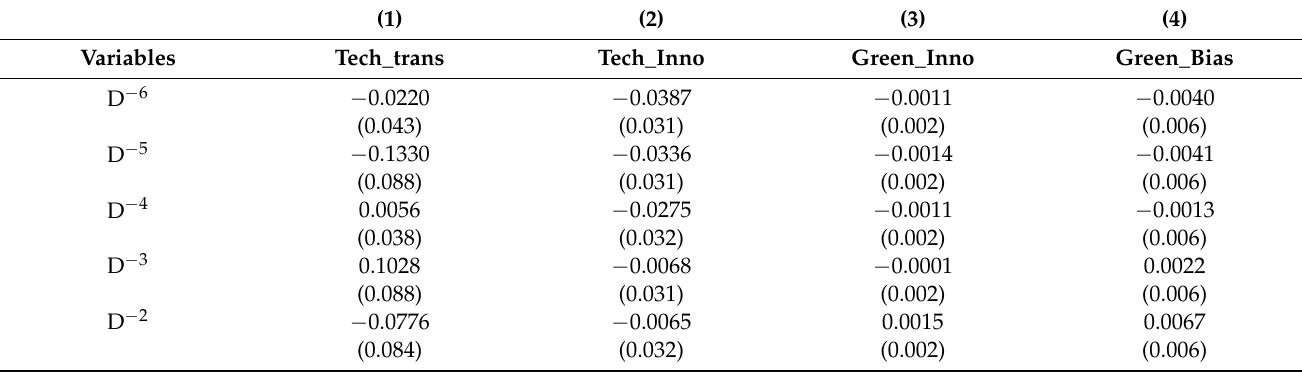
Table 11. Parallel trend test of mediating